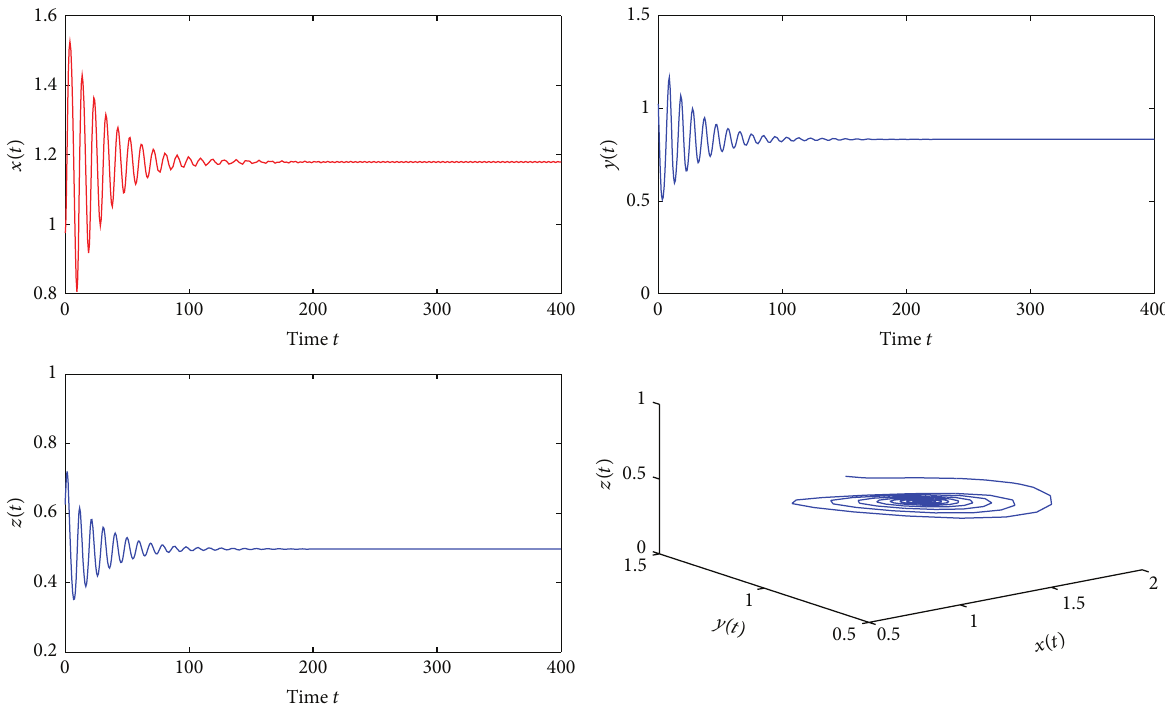
Figure 5: 𝐸 ∗ is asymptotically stable for 𝜏 1 = 0.75 < 𝜏 ∗ 1 = 0.8095 and 𝜏 2 = 0.8 with initial values 0.975, 1.025, and 0.625.